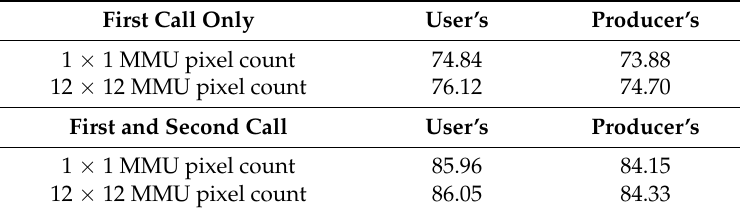
Table 7. Average accuracy for the land cover maps with 1 × 1 and 12 × 12 minimum mapping units